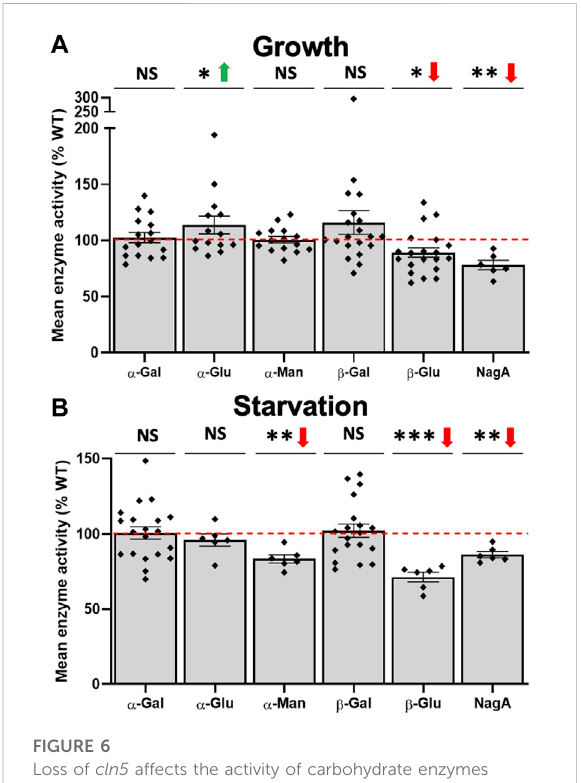
FIGURE 6 Loss of cln5 affects the activity of carbohydrate enzymes during growth and starvation. WT and cln5 -de fi cient cells during (A) growth and (B) 4-hour starvation were lysed and the activities of various carbohydrate enzymes were assessed including α - galactosidase ( α -Gal), β -galactosidase ( β -Gal), α -glucosidase ( α - Glu), β -glucosidase ( β -Glu), α -mannosidase ( α -Man), and N-acetylglucosaminidase (NagA). Raw enzymatic values were subtracted from the blank solution and activities in cln5 -de fi cient lysates were standardized against the activities in WT samples. Data presented as mean enzymeactivity(% WT)± SEM ( n ≥ 6). * p < 0.05, ** p < 0.01, *** p < 0.001 (one sample t -test). NS – not signi fi